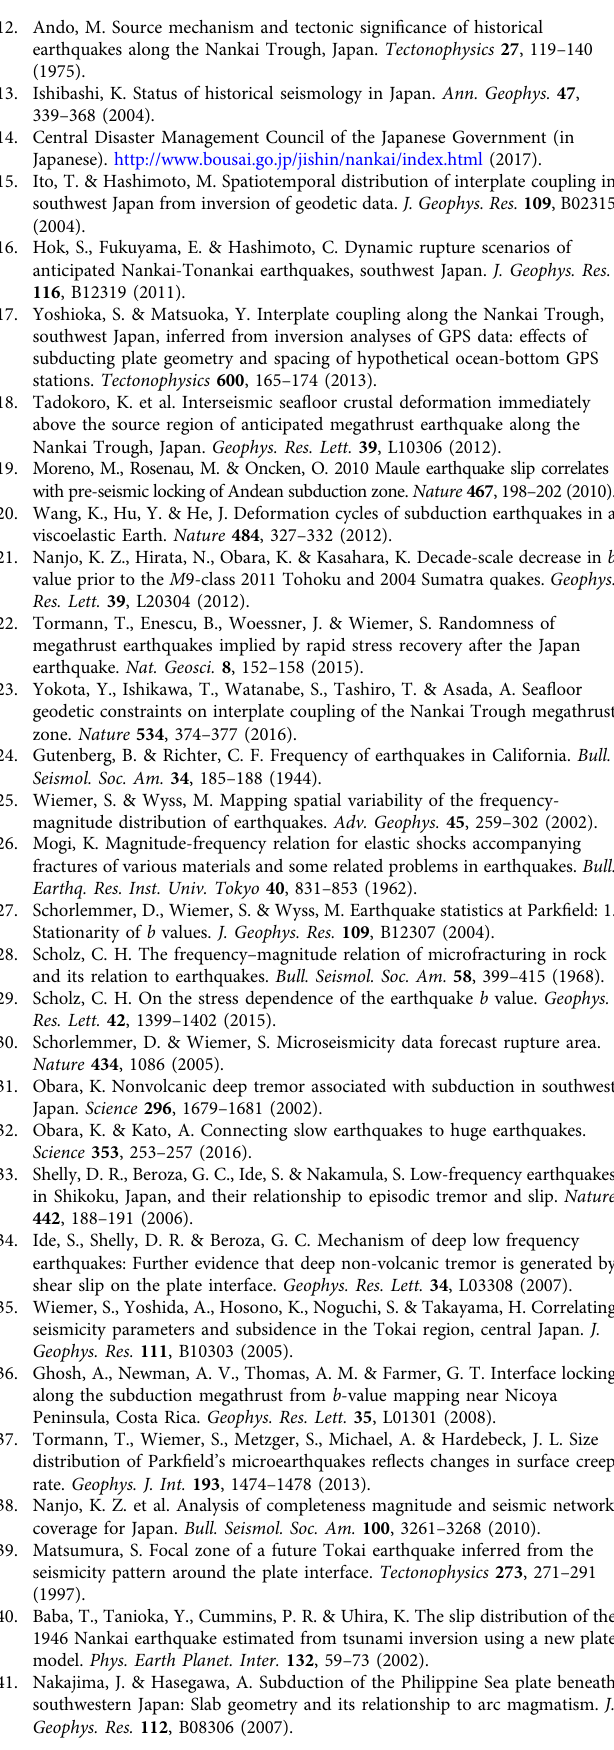
Table 2 of Yokota et al. 23 , showing the list of positions and SDR values, which we used in this study, was downloaded from https://www.nature.com/articles/ nature17632#supplementary-information. In creating map images in Fig. 1 and Supplementary Figs. 1a, 2-5, 6a, and 8, we used plate con fi guration data 40 – 43 , compiled and provided by Meteorological Research Institute. The data are pub- lically available at http://www.mri-jma.go.jp/Dep/sv/2ken/fhirose/en/en.Tools. html. Other information is available from the corresponding author upon rea- sonable